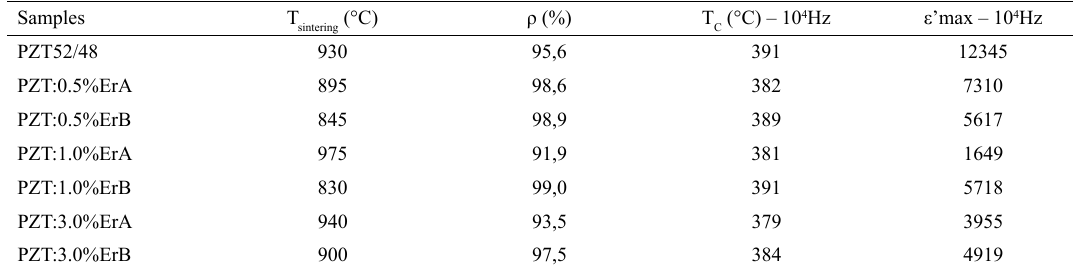
Table 3. Curie temperatures and dielectric constants (f = 10 4